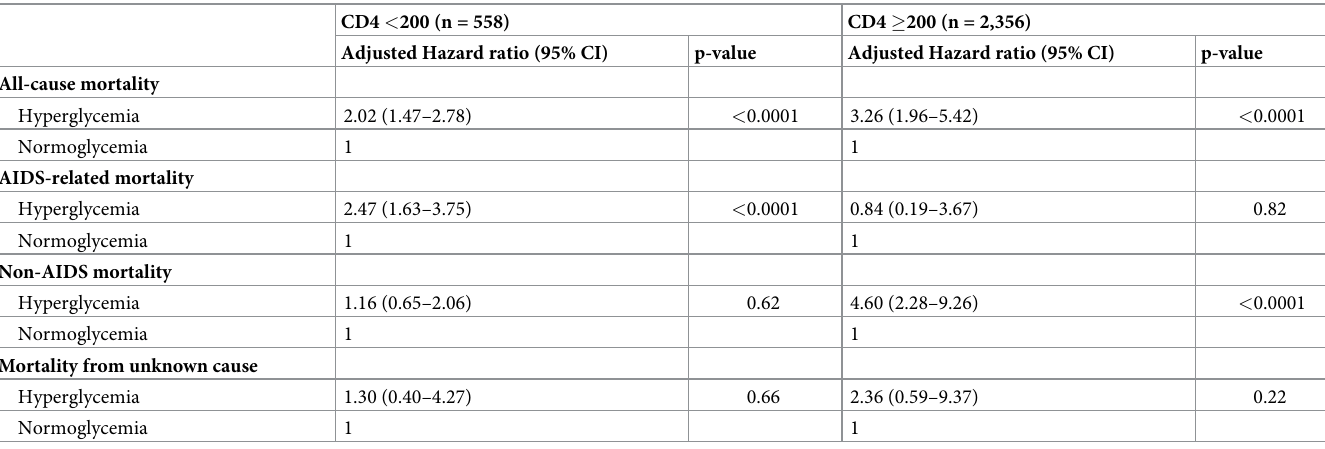
Table 3. Multivariate analysis of the association of hyperglycemia with all-cause and cause-specific mortality by baseline CD4 cell count (n =